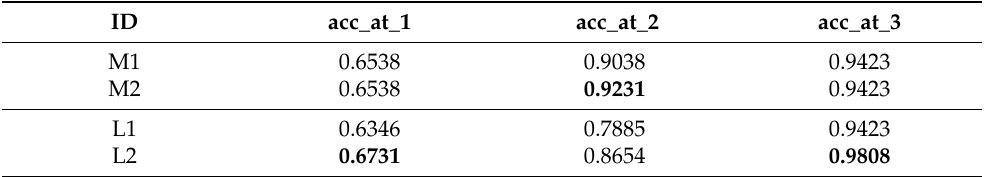
Table 5. Top-k accuracy score results of the best performing experiments. Multi-scale CNNs (M1), multi-scale CNNs with attention (M2), LSTM (L1), LSTM with attention